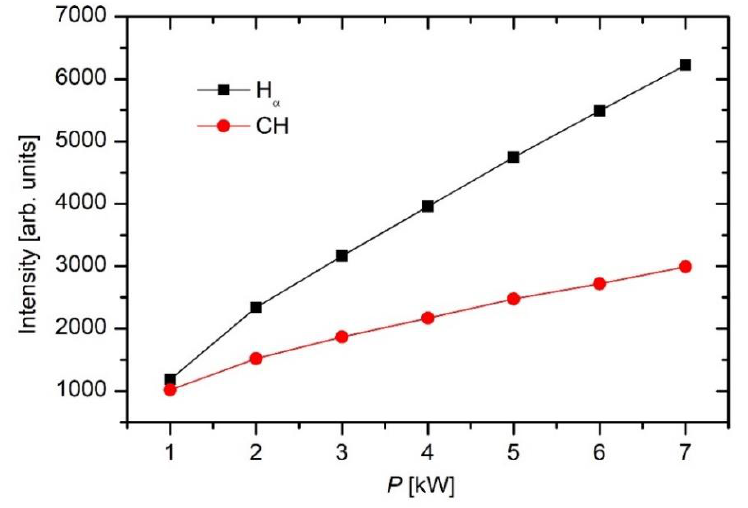
Figure 4. The intensity of the H α and CH lines at 656 nm and 431 nm as a function of the discharge power at 130 sccm HMDSO.